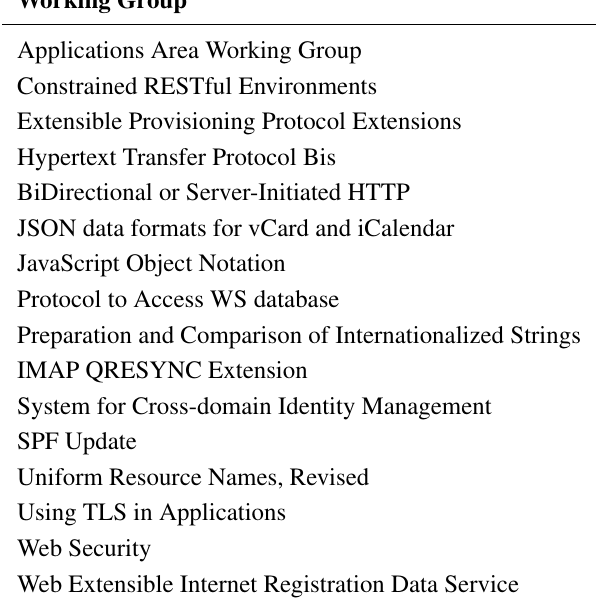
Table 7. Active IETF Working